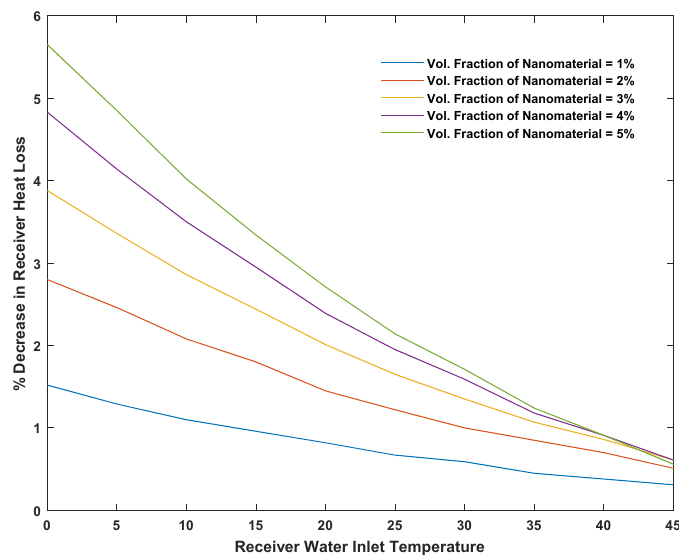
Fig. 7. Effect of volume fraction of the nanoparticle on receiver heat